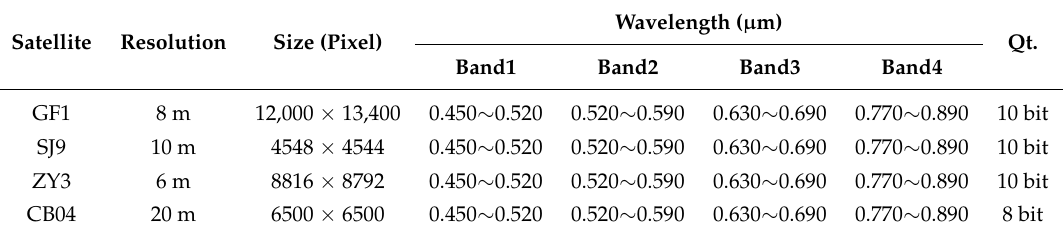
Table 2. Detailed information on experimental images. Key: Qt. =